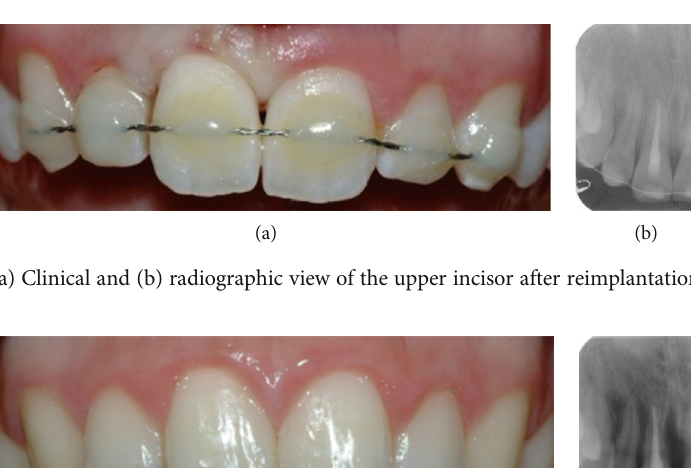
Figure 1: Posttraumatic (a) clinical and (b) radiographic view showing the absence of the upper right central incisor.